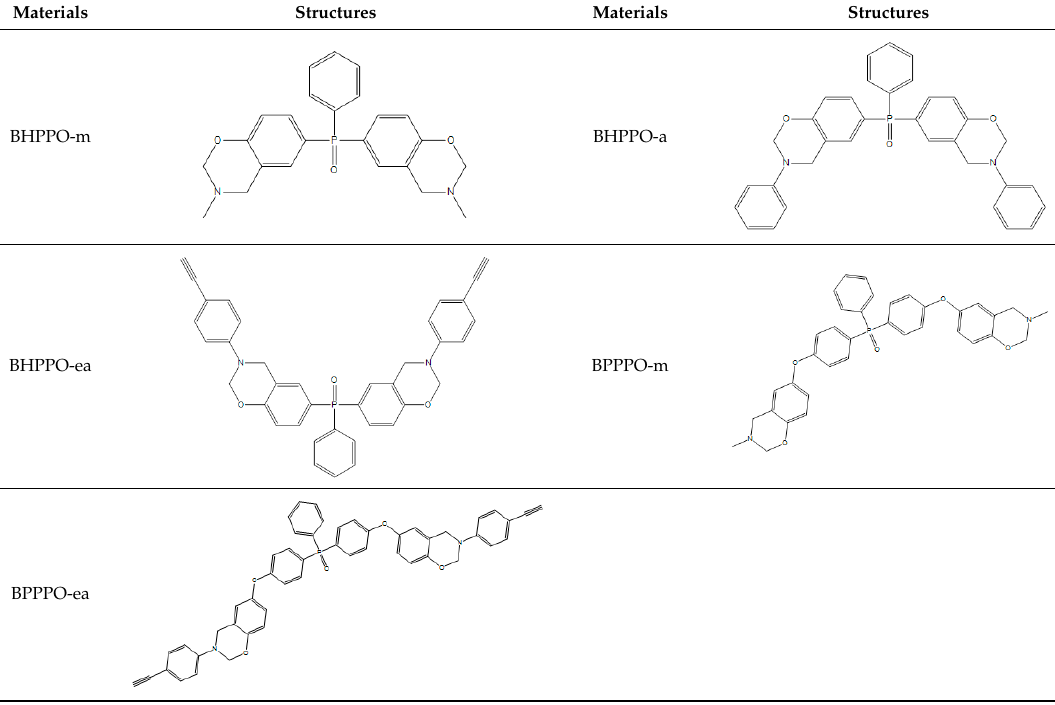
Table S1: Structures of benzoxazines in the training